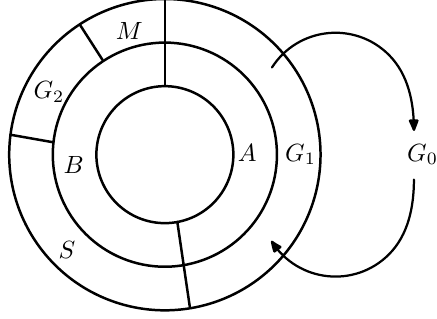
Fig. 1. Schematic model of the cell